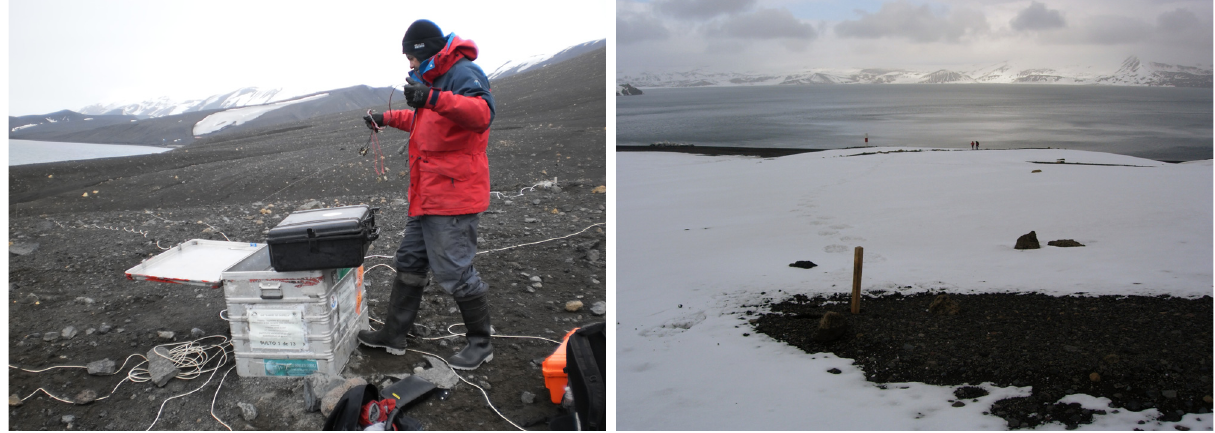
Figure 9. Left: installation of the array data acquisition system in the Fumarole Bay area during the 2010-2011 survey; right: reference stake in- dicating the position of one of the seismometers of the 12-channel seismic array deployed in the Fumarole Bay during the 2009-2010 survey.